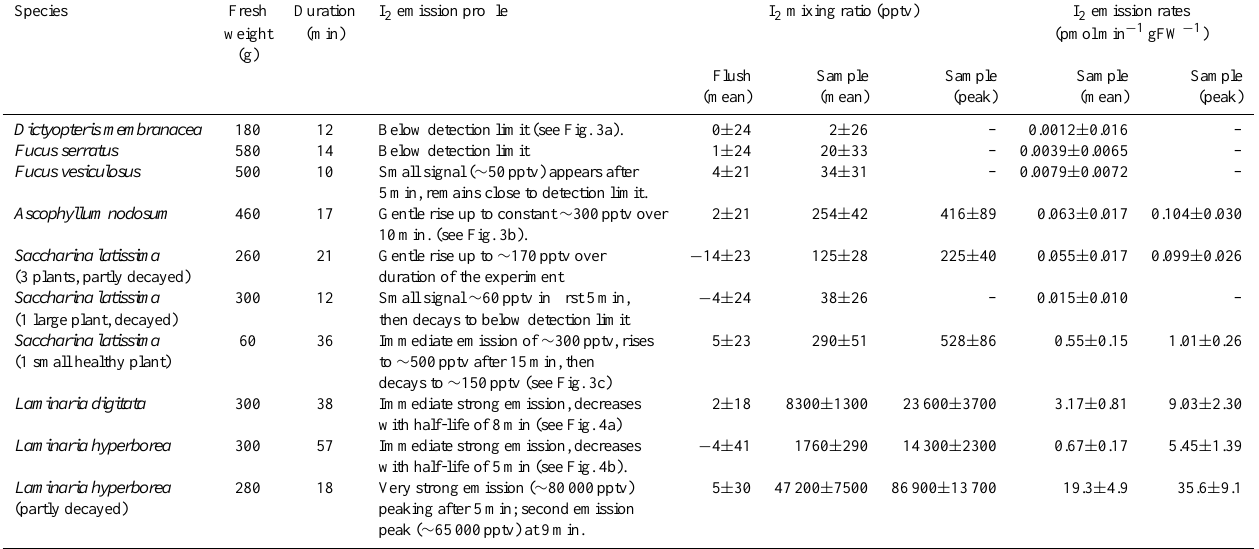
Table 1. Iodine mixing ratios, emission profiles and emission rates observed during air exposure experiments performed on whole seaweed